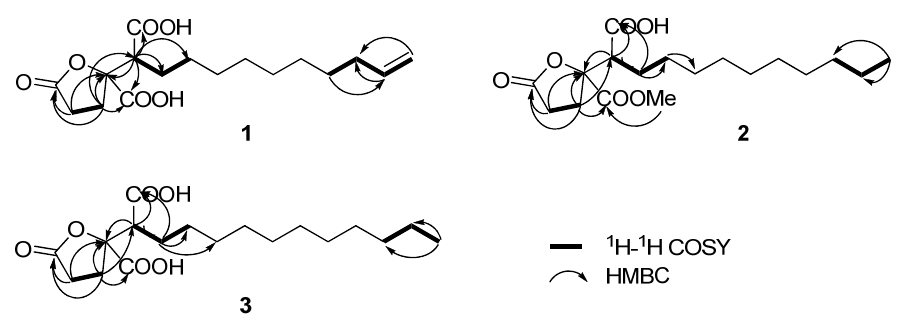
Figure 2. 1 H- 1 H COSY and selected HMBC correlations of compounds 1 – 3